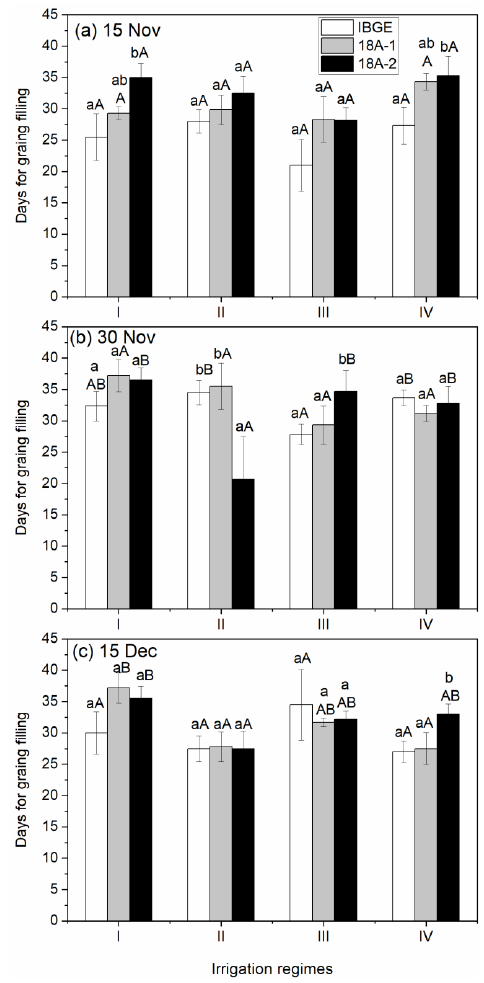
Figure 2. Effects of irrigation regimes on days for grain filling of wheat cultivars sown on different dates. Bars show mean values of six replicates from two growth cycles and contain standard errors of means ( n = 6). In each panel, bars under each irrigation regime with different lowercase letters show significant differences between wheat cultivars, and bars of each cultivar with different uppercase letters show significant differences between irrigation regimes at p < 0.05. I — irrigation at tillering stage; II — irrigations at tillering and booting stages; III — irrigations at tillering, booting, and flowering stages; IV — irrigations at tillering, booting, flowering, and grain filling stages. Nov = November, Dec = December.